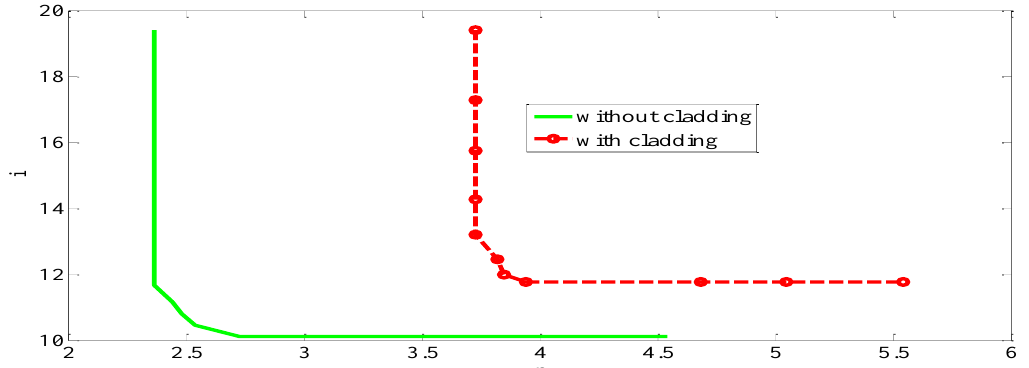
Fig. 17. Non dimensional parameter pi diagrams of the structures withoutandwith cladding material for Blast load acting on front wall (19)